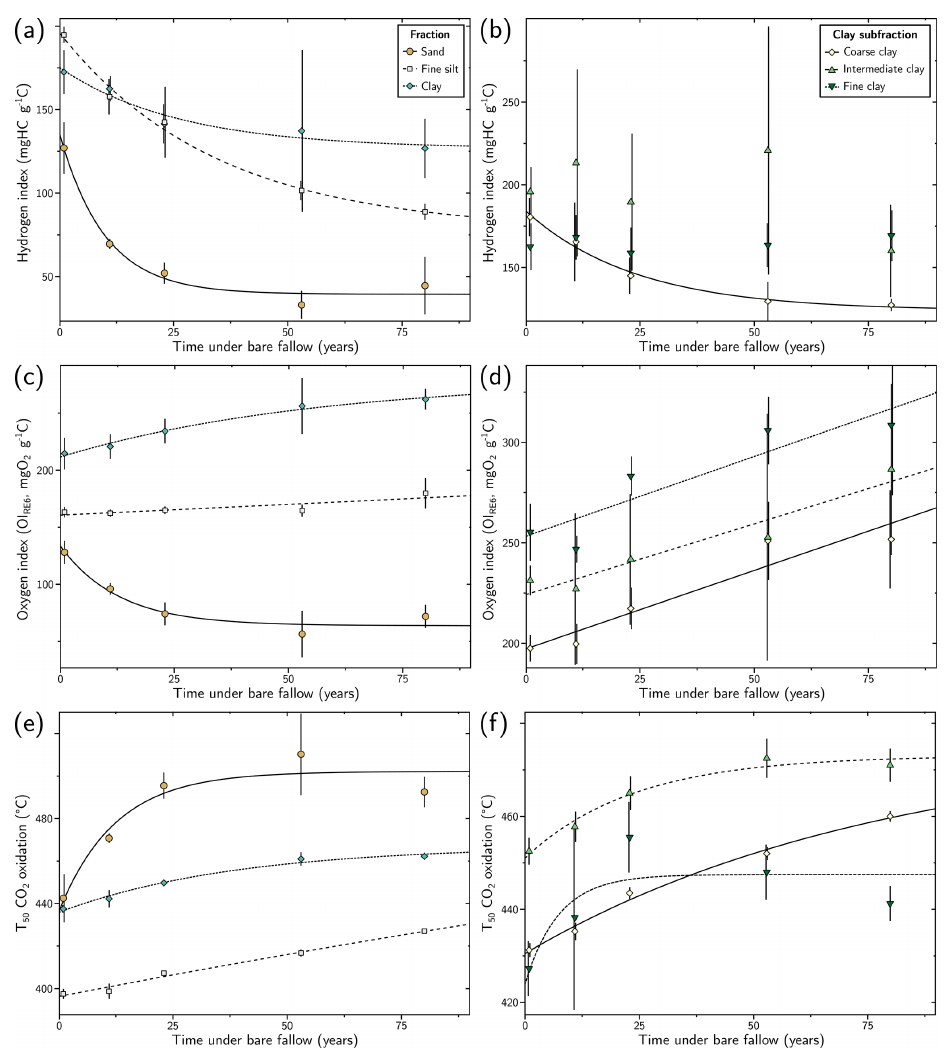
Figure 3. Evolution of selected Rock-Eval 6 parameters with duration of the long-term bare-fallow experiment for the studied size fractions: (a) and (b) hydrogen index, (c) and (d) OI RE6 oxygen index and (e) and (f) the temperature at which 50% of organic carbon combusted during the Rock-Eval 6 oxidation step ( T 50 CO 2 oxidation). In (a) , (c) and (e) , the results for the sand ( > 50µm), silt (coarse: (20–50)µm, fine: (2–20)µm) and clay ( < 2µm) fractions are given. In (b) , (d) and (f) , the results for the coarse ((0.2–2)µm), intermediate ((0.05–0.2)µm) and fine ( < 0.05µm) clay subfractions are represented. The error bars correspond to 2 standard deviations calculated from the four plot replicates. Where not visible, error bars are smaller than symbol size. For each fraction, the trend of each parameter as a function of bare-fallow duration is fitted by either exponential decay, exponential recovery or linear functions to guide the